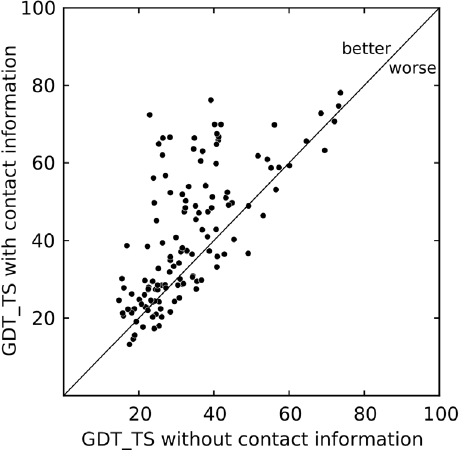
Figure 8. Comparison of abinitio structure prediction of 132 proteins from EPC-map_test with and without predicted contacts: each data point corresponds to the GDT_TS of the lowest-energy structure generated with and without the use of EPC-map predicted contacts. EPC-map increases the average prediction accuracy by 7.8% from 33.1 to 40.9 GDT_TS (paired Student’s t -test p -value v 10 { 10 ).